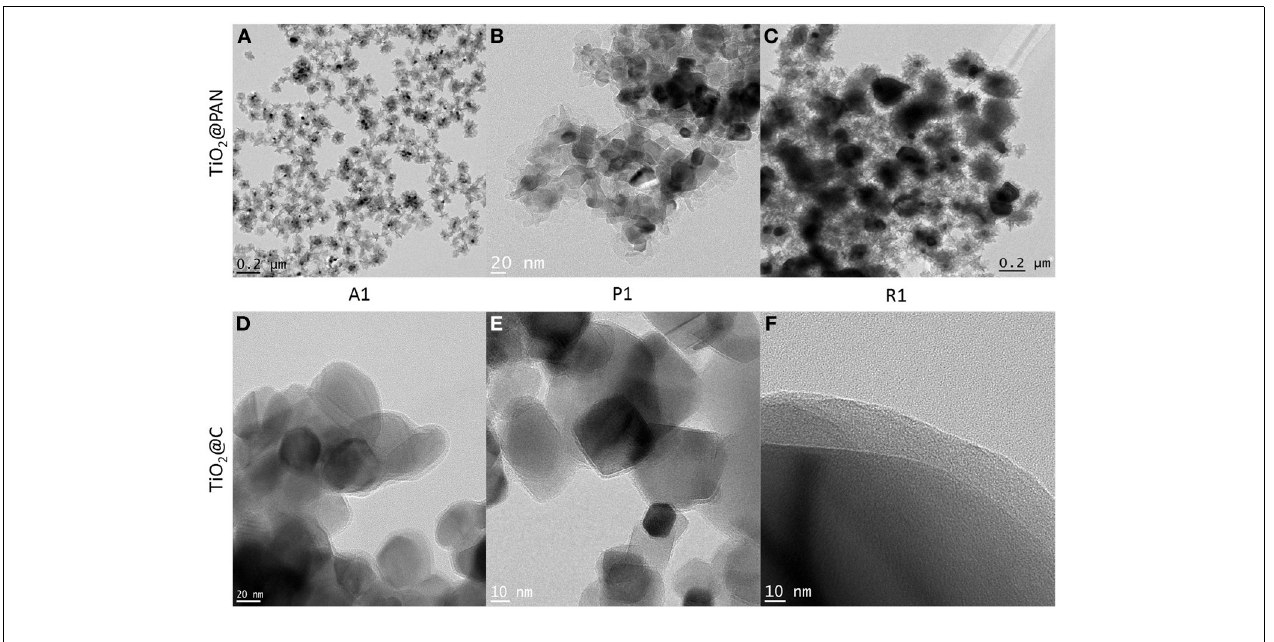
FIGURE 2 | TEM pictures of TiO 2 @PAN nanoparticles (A–C) and